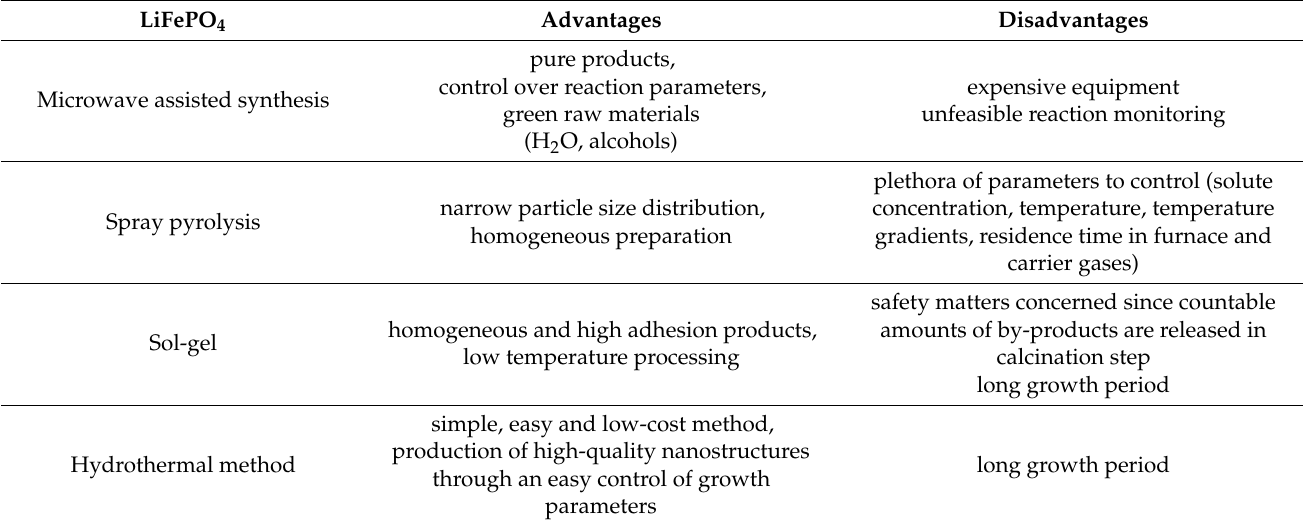
Table 2. Comparison of growth